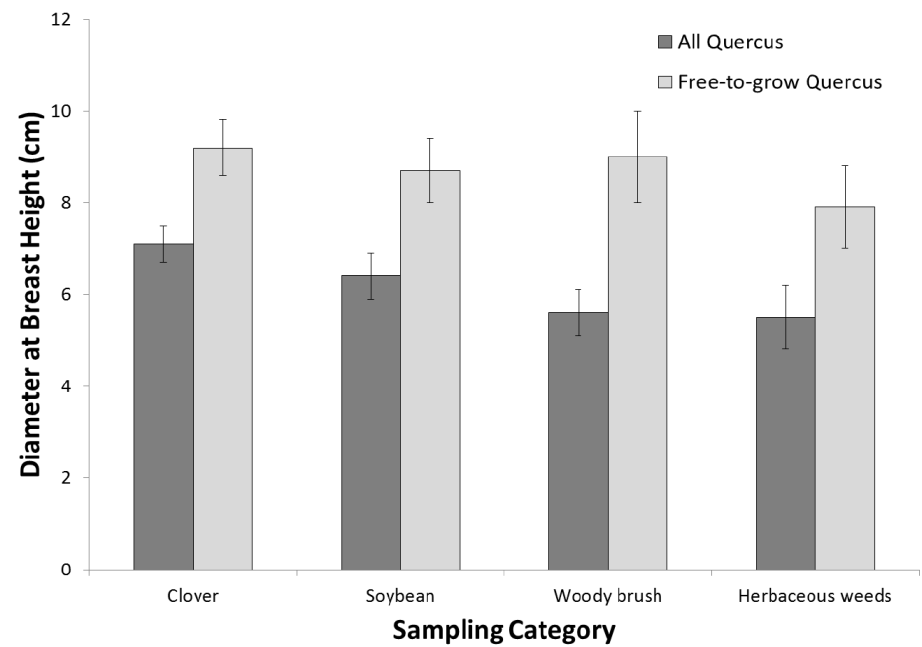
Figure 2. Diameter at breast height (DBH; ± S.E.) of all Quercus stems and free-to-grow Quercus stems by Land Cover Type (LCT). There was no significance among the four LCT regarding DBH for all Quercus stems and free-to-grow Quercus stems, F = 2.15, p = 0.11, F = 1.48, p = 0.25, respectively.